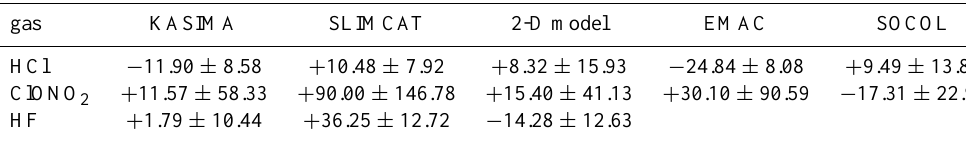
Table 3. Mean differences between models and FTIR measurements in % (calculated as (model-meas)/meas) averaged over all sites, and their standard deviations, for HCl, ClONO 2 , and HF. The differences for KASIMA and SLIMCAT were calculated from the daily values, while for EMAC, SOCOL, and the 2-D model, the monthly means were used.